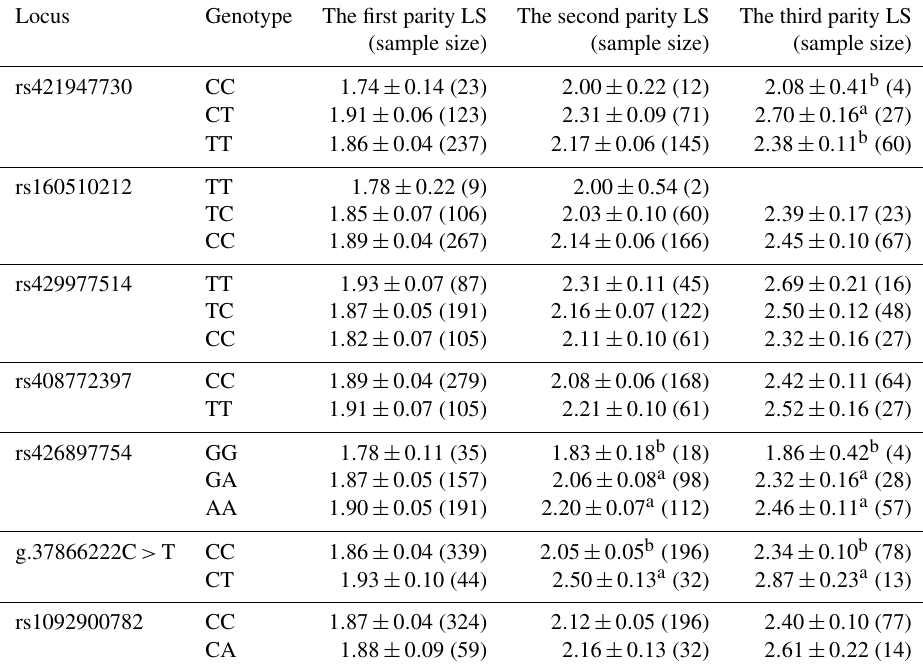
Table 4. LSM (least square means) ± SE (standard error) of the litter size of three different parities in Small-tailed Han sheep with different genotypes. Note that the different subscript letters in the table indicate differences among the groups ( p < 0 .